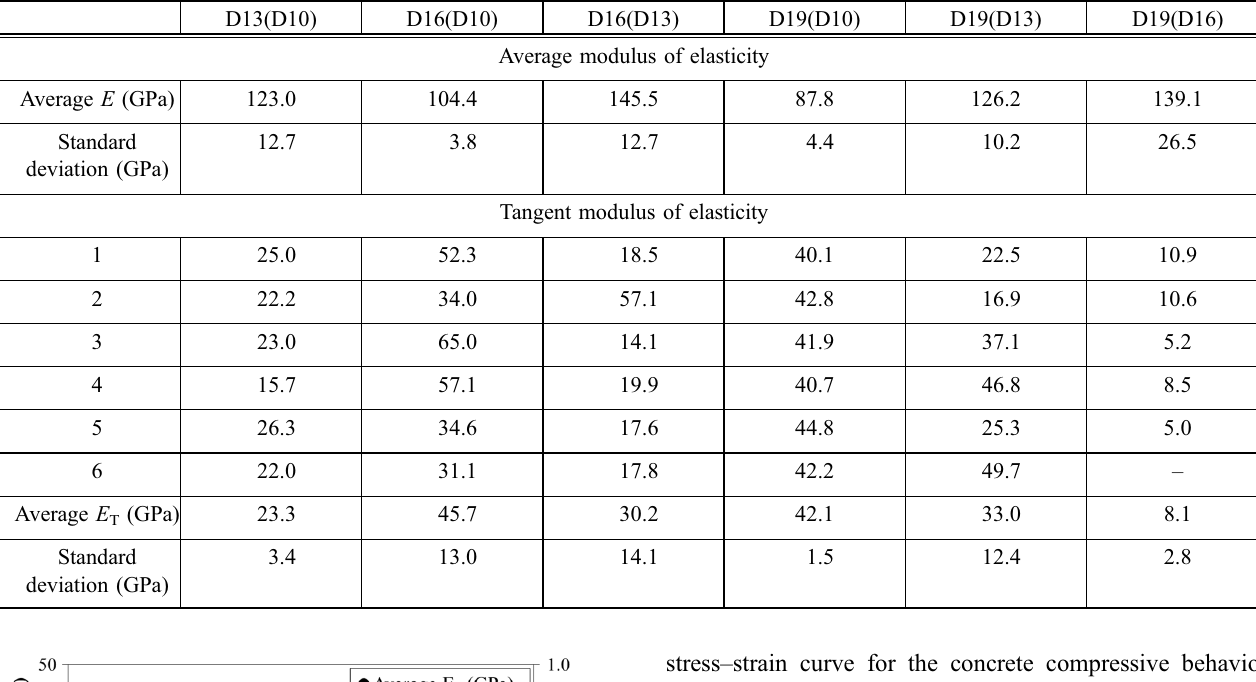
Table 3 Average modulus of elasticity and tangent modulus of